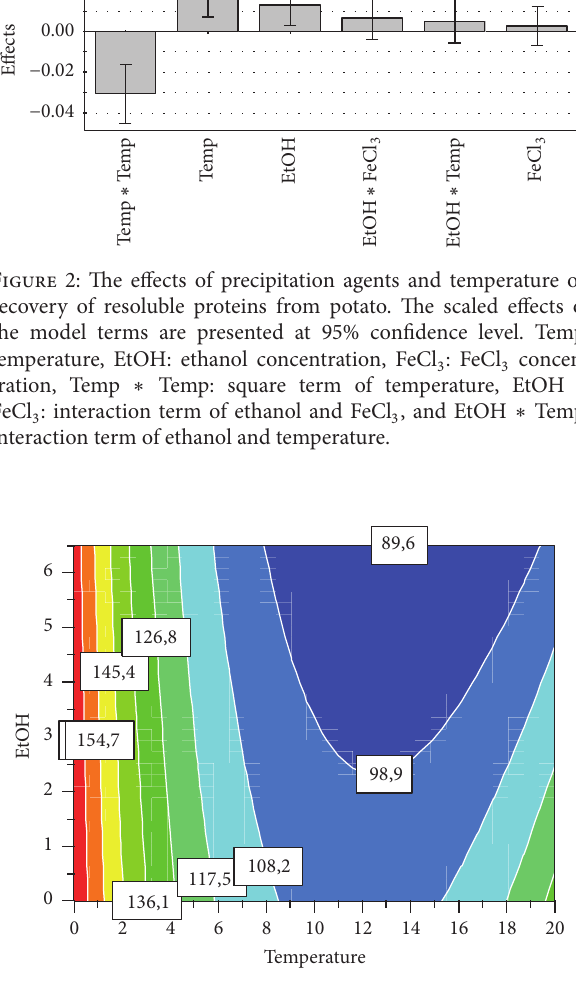
Figure 3: Prediction of favorable ethanol concentration and tem- perature within the investigated region to achieve highest possible quantity of resoluble proteins.